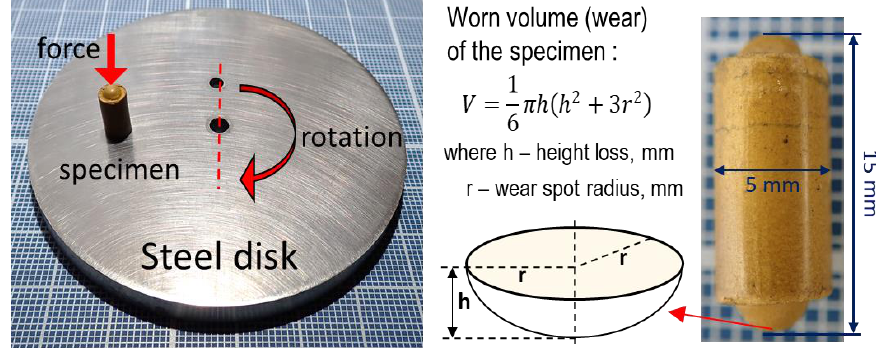
Figure 3. Pin-on-disk sliding wear test and determination of wear of the specimen. r —radius of the wear spot of the sample,